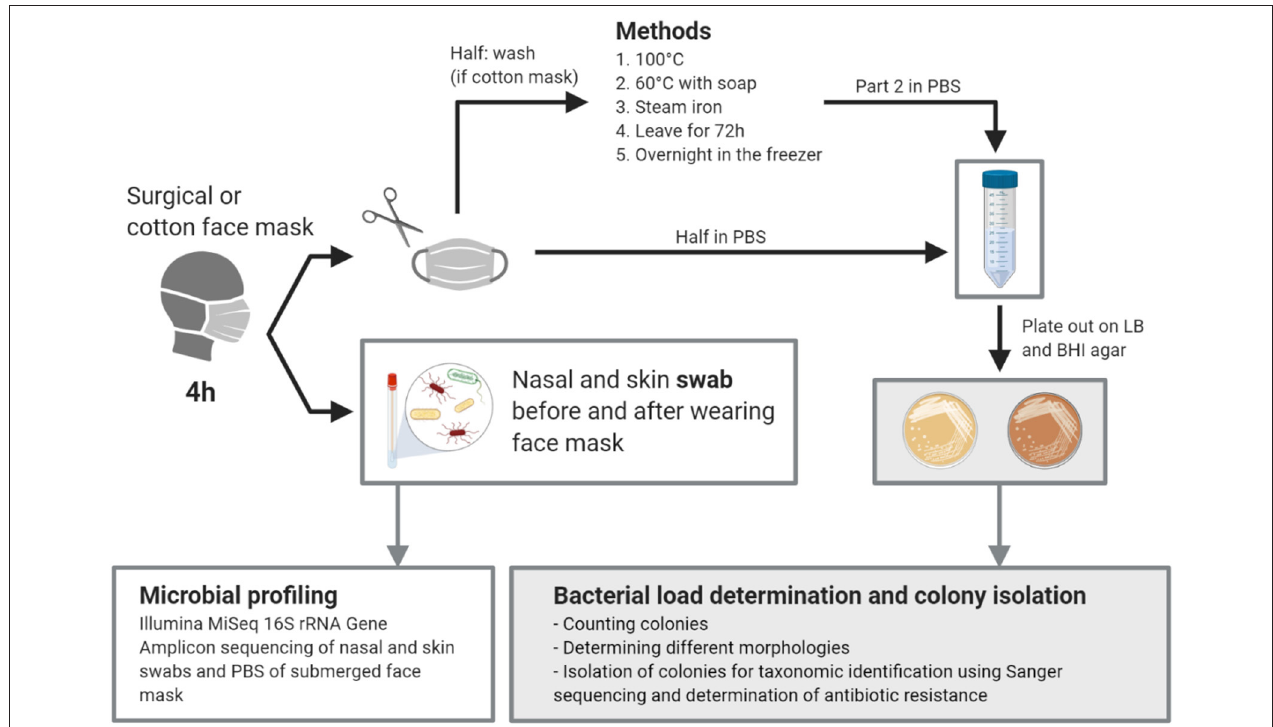
FIGURE 1 | Graphical abstract of the study. Created with BioRender.com.